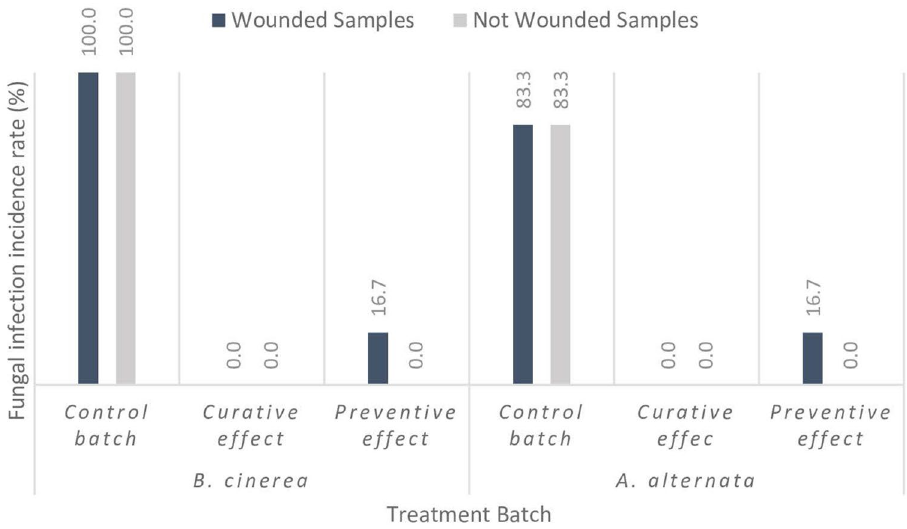
Figure 8. Percent infection rate of wounded and not-wounded cherry tomato samples inoculated with A. alternata and B. cinerea without PJ-WS-LE extract treatment and with PJ-WS-LE extract treatment applied to evaluate curative and preventive effects.